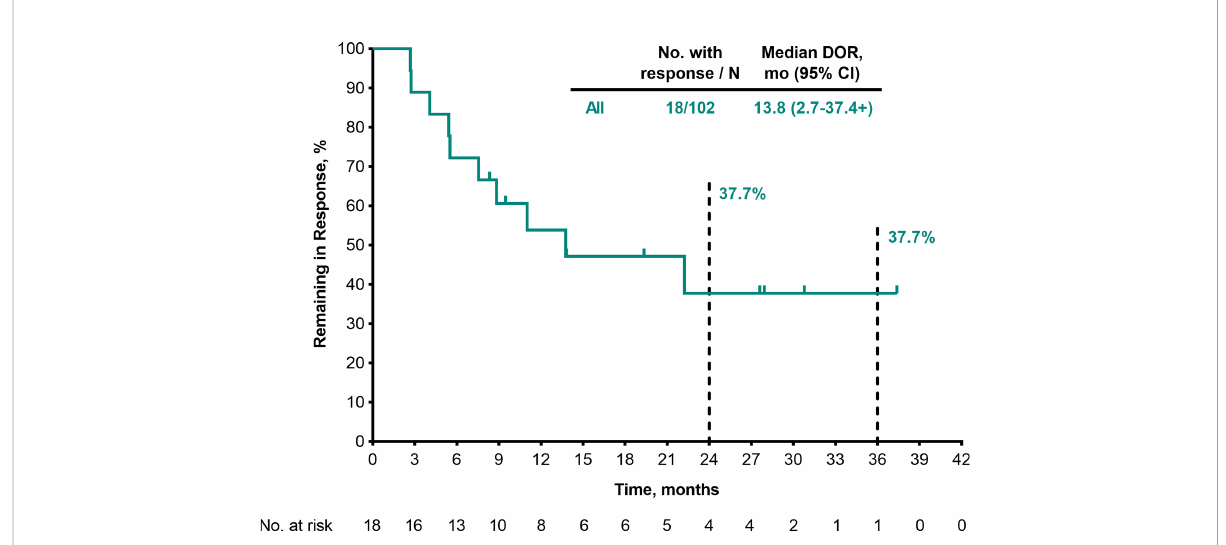
FIGURE 1 DOR per RECIST v1.1 by BICR (patients with response in the FAS population). BICR, blinded independent central review; DOR, duration of response; FAS, full analysis set; RECIST v1.1, Response Evaluation Criteria in Solid Tumours, version